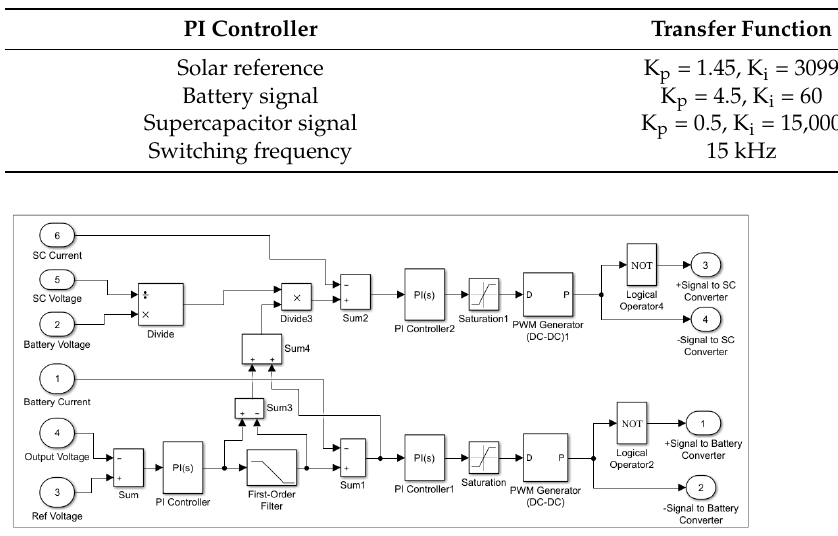
Figure 11. Control system with PI controllers for battery and supercapacitor.